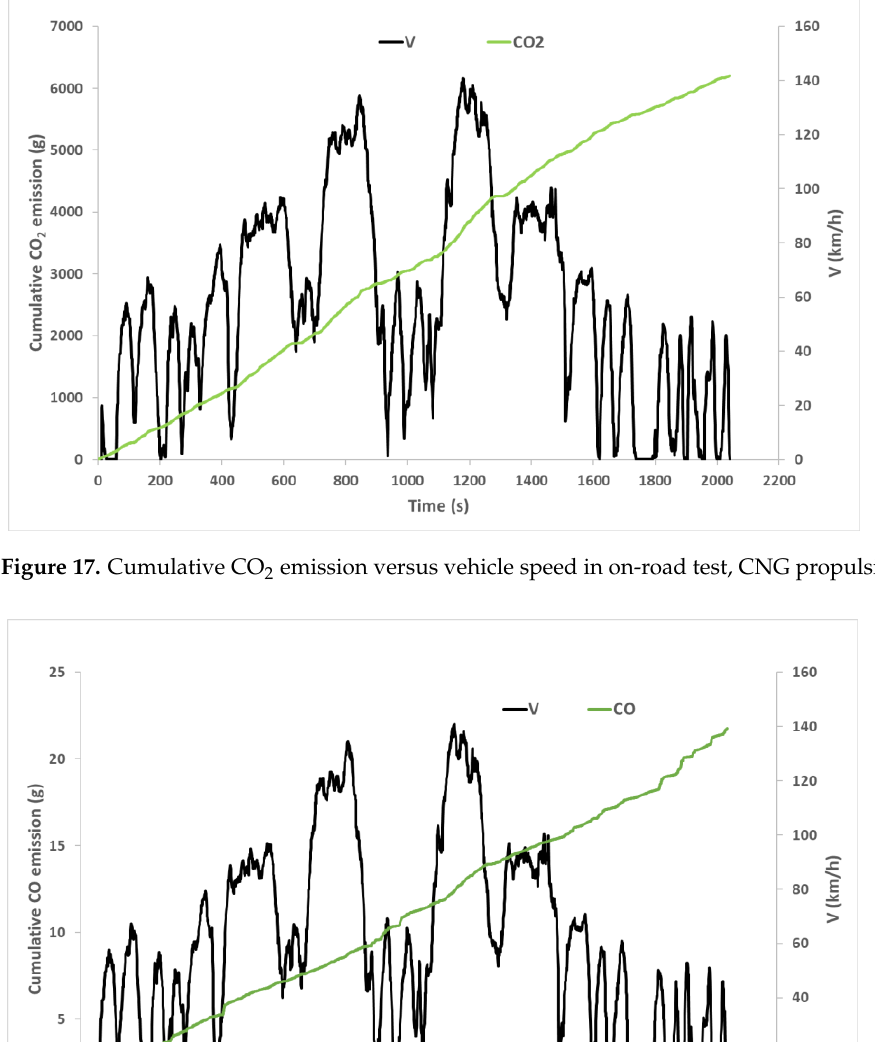
Figure 16. Cumulative CO emission versus vehicle speed in on-road test, petrol propulsion.